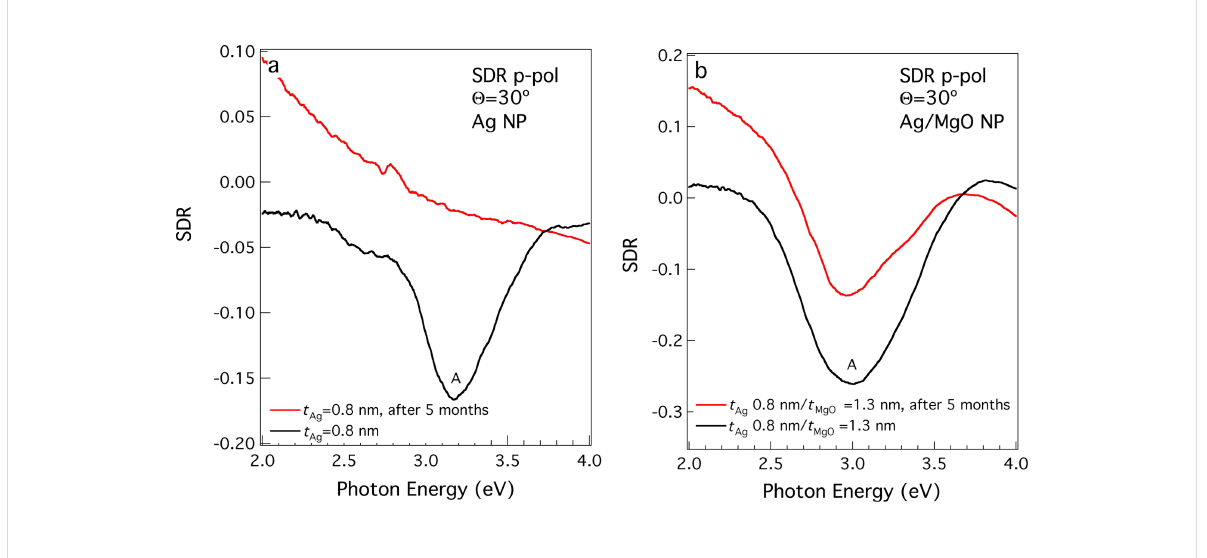
Figure 5: (a) SDR spectra taken under p-polarisation excitation at Θ = 30° on Ag NPs deposited on Si/SiO x after few days (black curve) and after five months of exposure to air. (b) Same as (a) but with Ag NPs co-deposited with MgO.